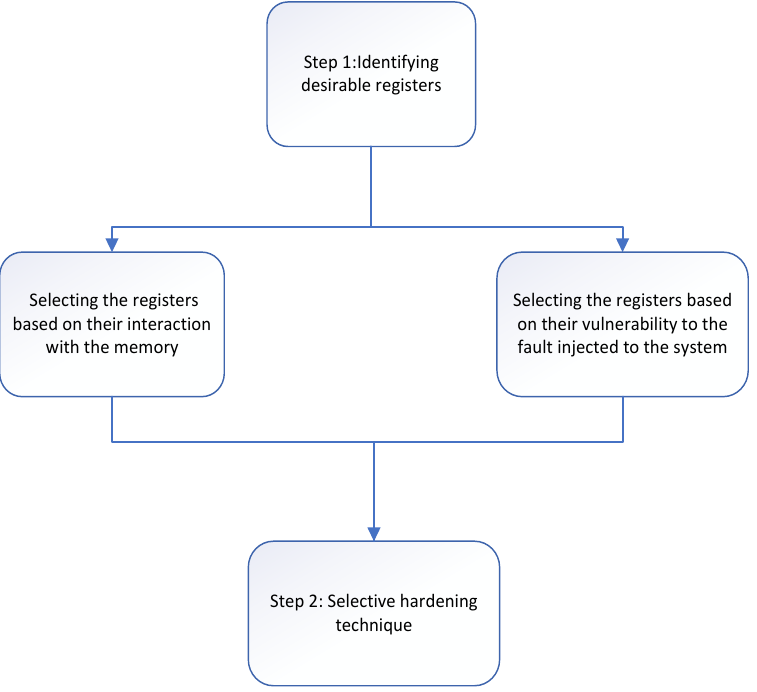
Figure 1. The abstract pictorial representation of the